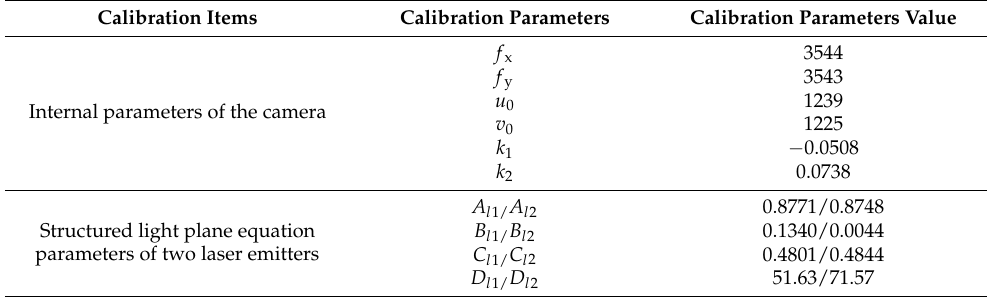
Table 2. Calibration results of internal parameters for vision sensor.